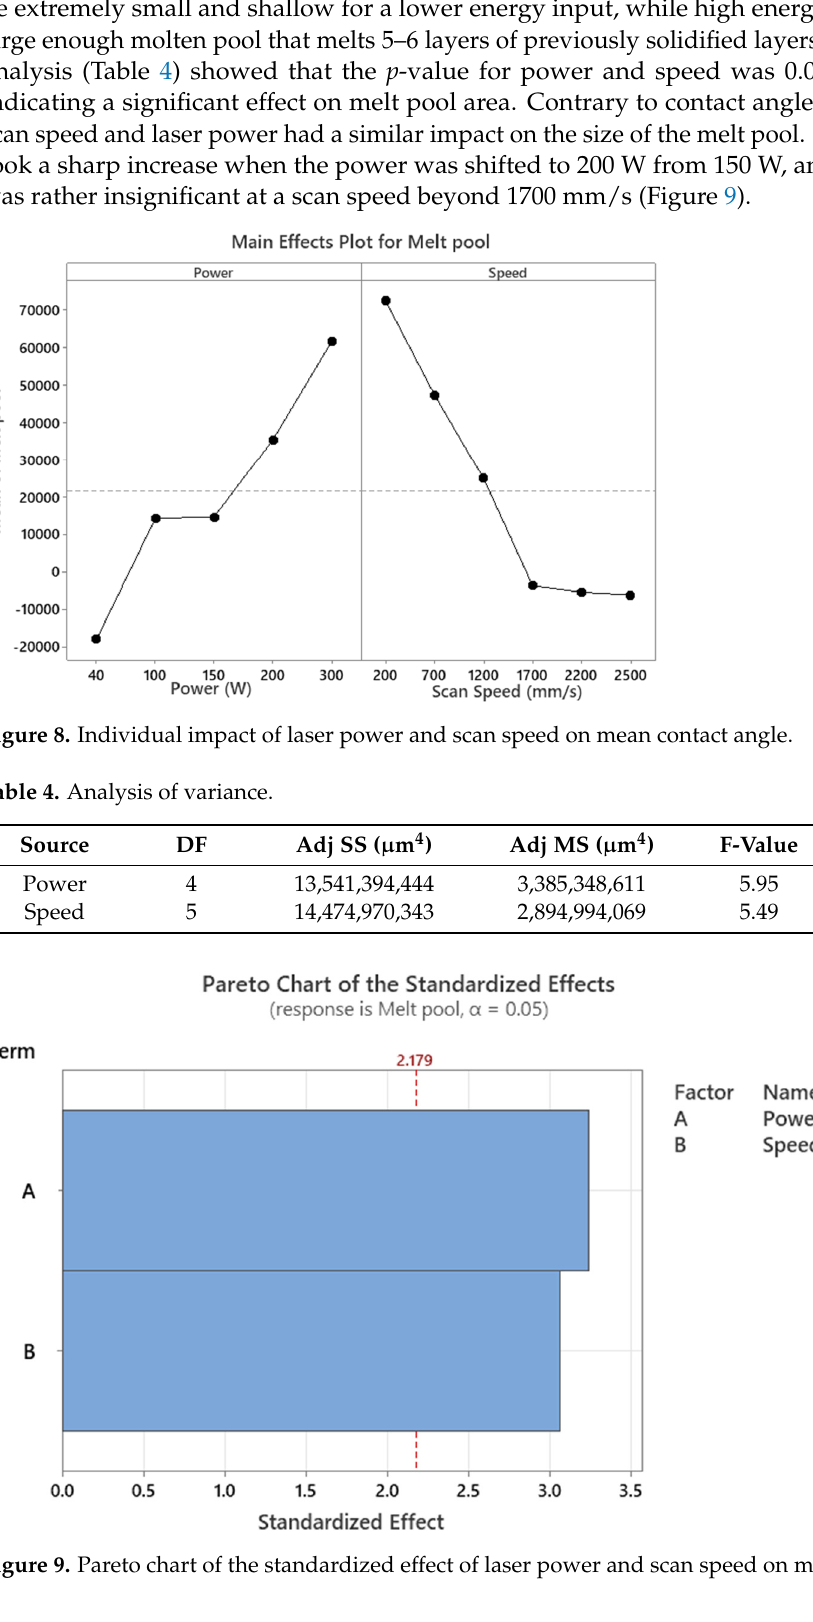
Figure 9. Pareto chart of the standardized effect of laser power and scan speed on melt pool